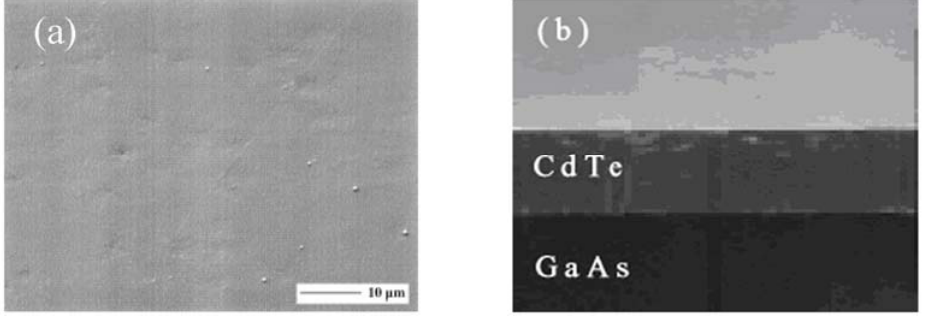
Figure 6. SEM micrographs of (a) surface plan view and (b) cleaved cross section of a CdTe epilayer on GaAs